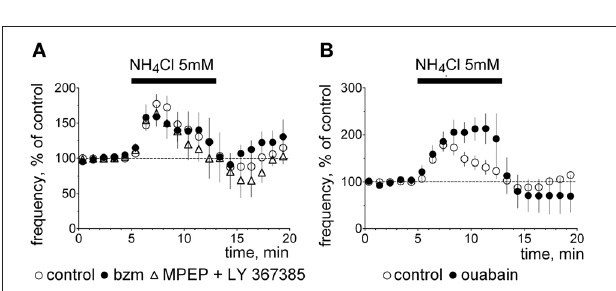
FIGURE 4 | Benzamil or ouabain abolish acid-induced excitation. (A1) Benzamil (bzm, 20 μ M) blocks acid-induced excitation. (A2) Time course of firing frequency in control and in ouabain (0.5 μ M). (A3) gray trace shows acid-induced outward current recorded in ouabain (perforated patch-clamp mode) superimposed to the black (control) response recorded from the same neuron. (B,C) Models explaining action of bzm or ouabain. Bzm inhibits ASIC,